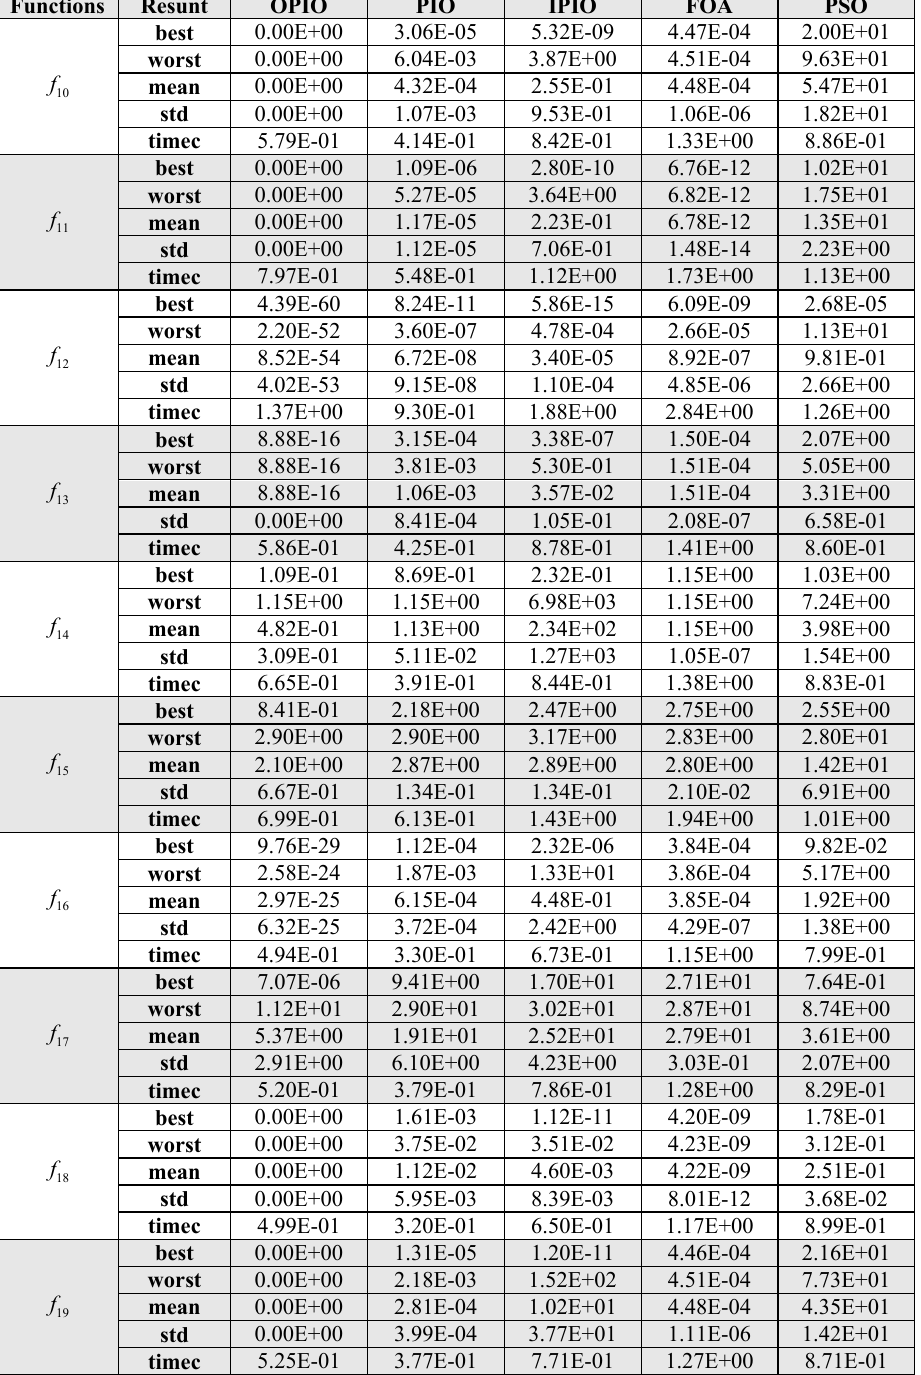
Table 3. Test results of High-dimensional Multimode